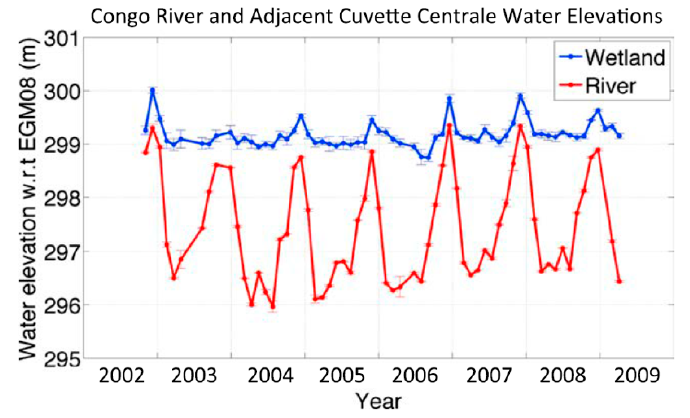
Figure 21. Water surface elevations for the Congo River and immediately adjacent wetlands of the Cuvette Centrale at 17.54° E, 0.74° S. Elevations are from the EnviSat radar altimeter, pass number 973. Elevations are with respect to the EGM08 geoid model [103].